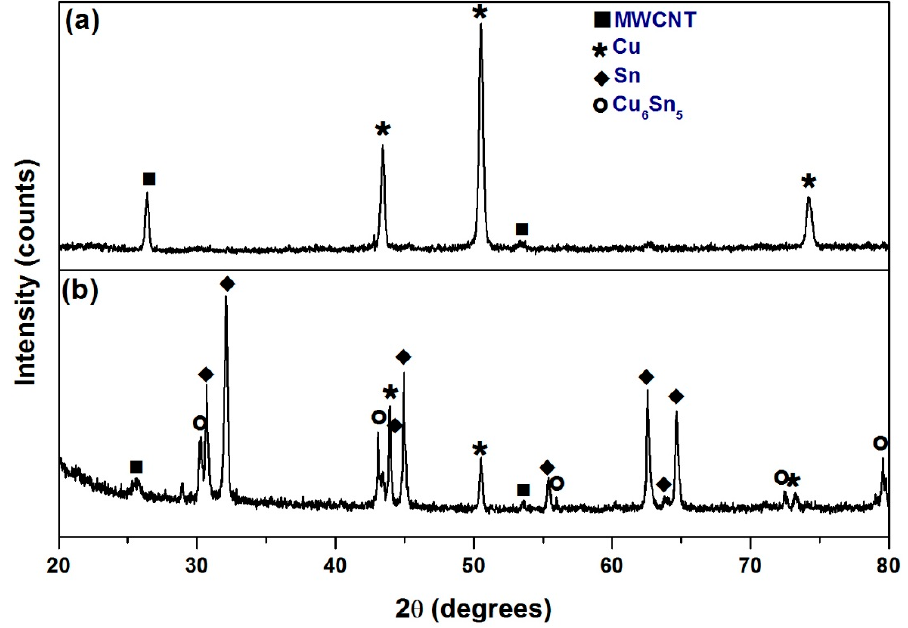
Figure 1. XRD analysis of ( a ) Cu-MWCNT (multi-walled carbon nanotube) composite; ( b ) Sn coated MWCNT composite